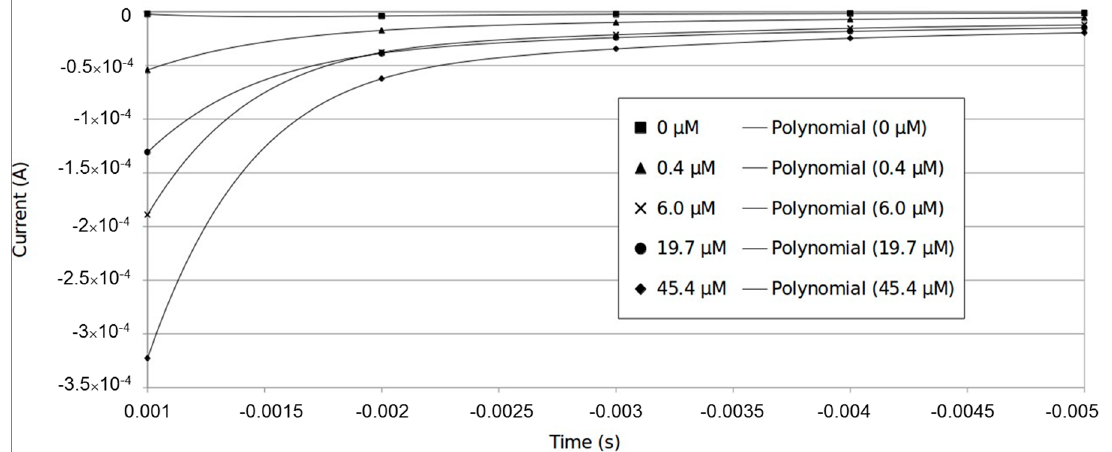
Figure 3. Experimental Results. The chronoamperometric plots show the time-dependency of the current during the reduction of TMBox at the working